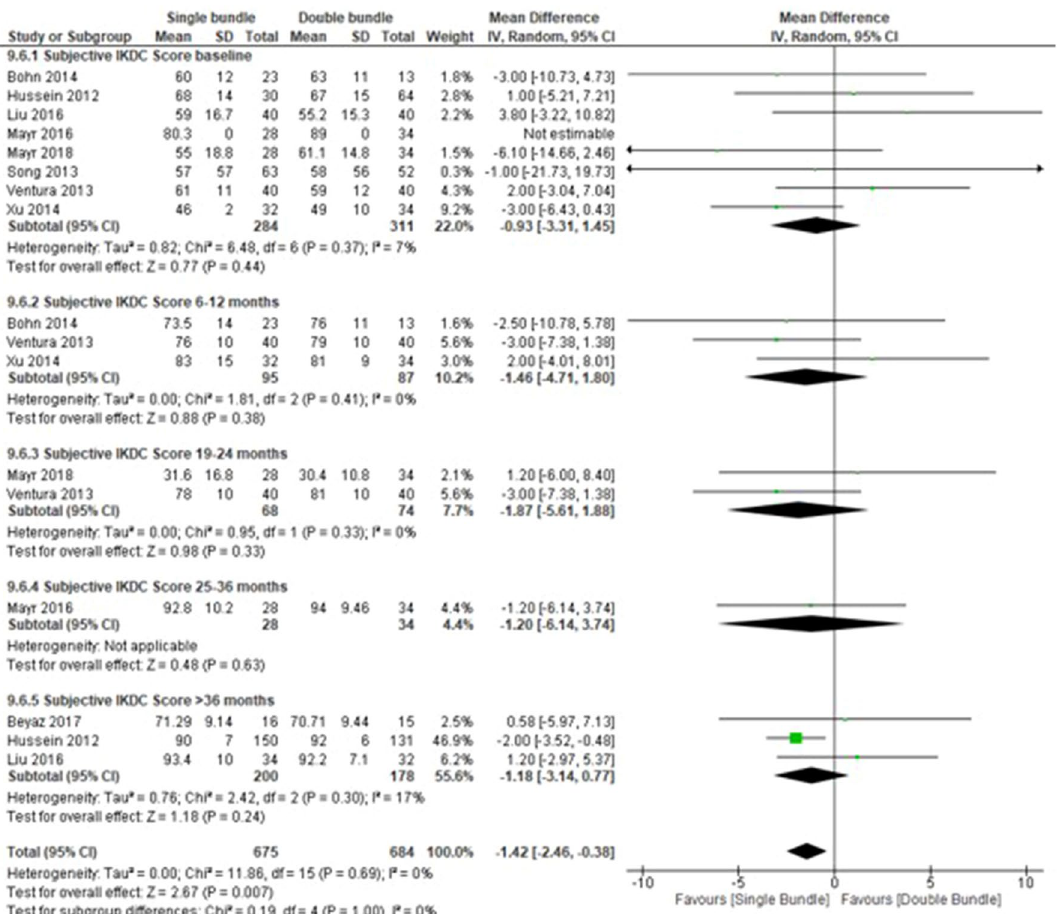
Figure 3. Forest plots of knee functionality data outcomes for single-bundle versus double-bundle reconstruction. Weights are from random-effects analysis. ( A ) Continuous data for the Subjective IKDC score (8 studies in the baseline period, 654 patients; 4 studies in the 6–12-month period, 150 patients; 1 study in the 19–24-month period, 78 patients; 2 studies in the 25–36-month period, 101 patients and 5 studies in the > 36-month period, 536 patients). Heterogeneity was low: τ 2 = 0.00; χ 2 = 11.86, df = 15 ( P = 0.69); I 2 = 0%